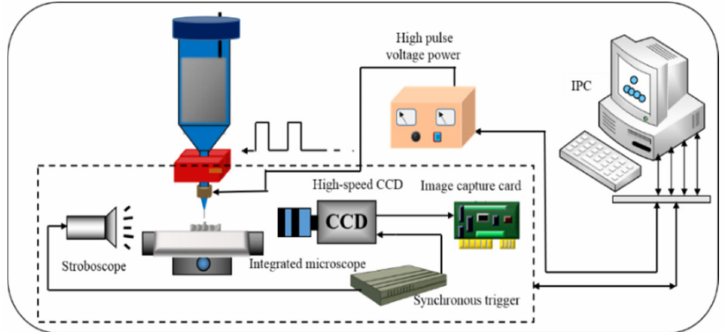
Figure 3. Schematic diagram of a high-speed monitoring